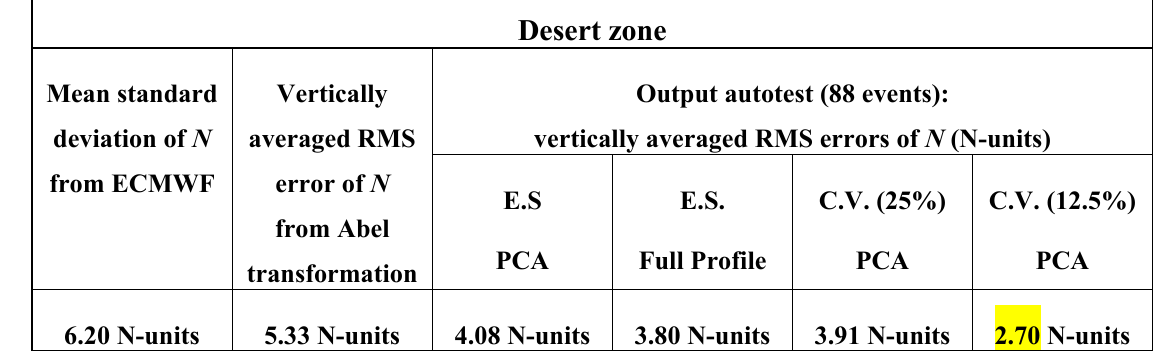
Table 4. Vegetation zone: mean standard deviation of ECMWF refractivity N , vertically averaged RMS error of refractivity N from Abel transformation and vertically averaged RMS error of refractivity N as output of neural network autotest (312 events) using the different approaches. E.S.: Early Stopping; C.V.: Cross Validation. The best result is